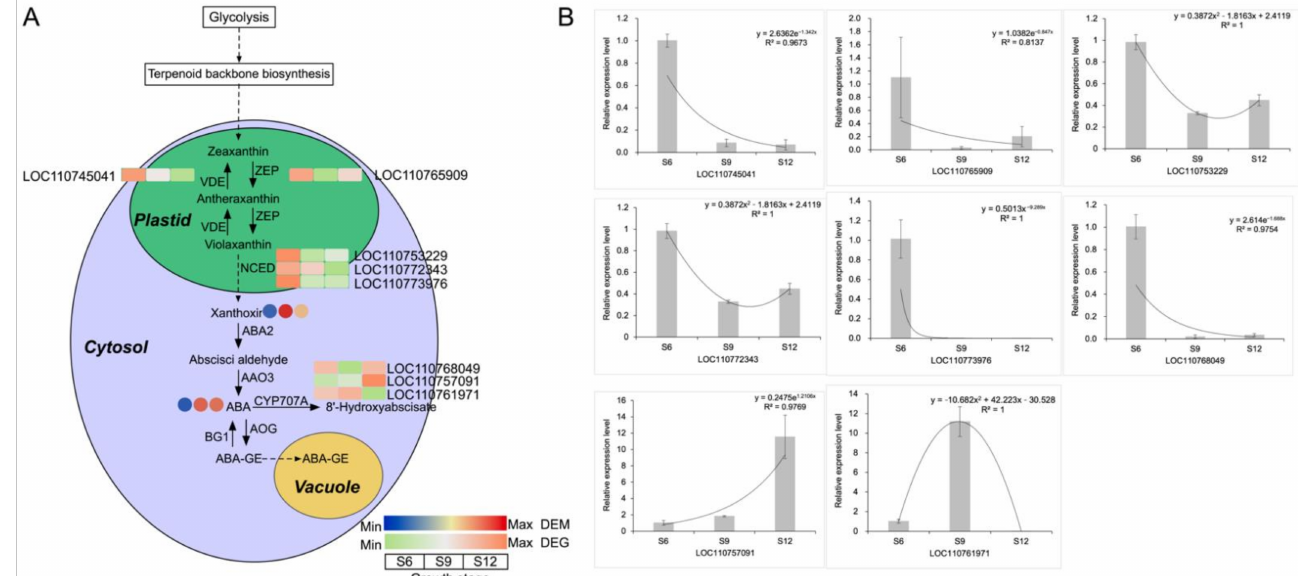
Figure 7. ABA synthesis pathway and gene expression analysis. ( A ) Schematic representation of the core pathway of ABA biosynthesis. The circle heat map represents the expression of DEMs in the three developmental stages, and the square heat map represents the expression of DEGs in the three developmental stages. ( B ) qRT-PCR analysis of ABA biosynthesis-related